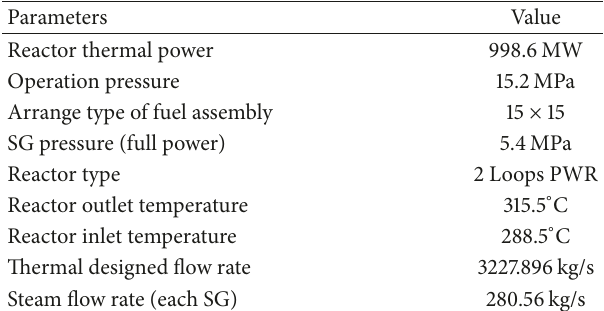
Table 1: The main parameters of Chashma